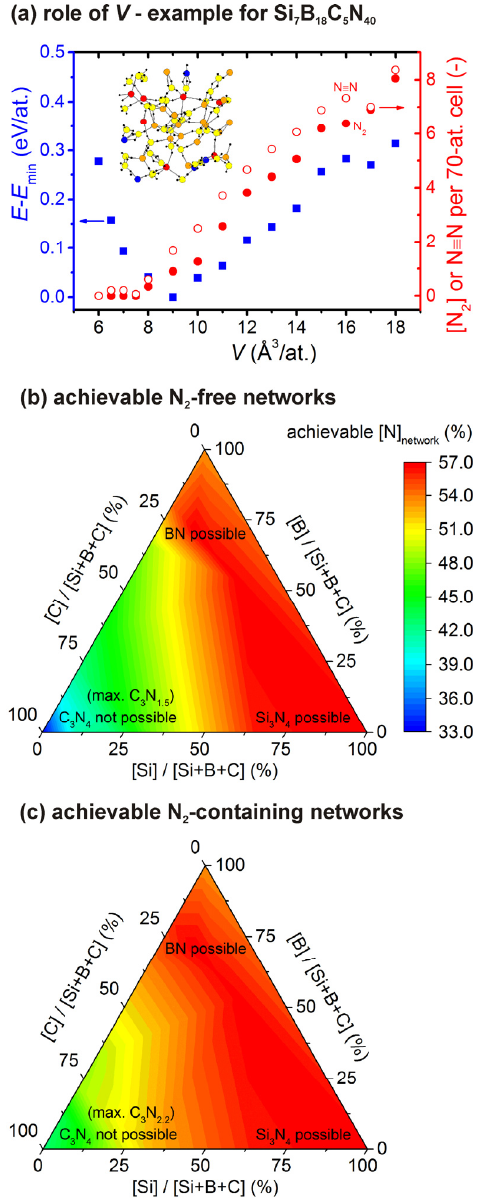
Figure 2. Panel ( a ) shows an example of the dependence of energy ( E - E min ; squares; left axis), number of unbonded N 2 molecules ([N 2 ]; full balls; right axis) and number of triple N ≡ N bonds (empty balls; right axis) on the inverse atomic density ( V ) for the composition of the 70-atom cell Si 7 B 18 C 5 N 40 . The inset is a snapshot taken at V = 9 Å 3 (red Si, orange B, blue C, yellow N, small black WFCs). Panels ( b , c ) show the maximum achievable content of N bonded in Si-B-C-N networks ([N] network ) without unbonded N 2, i.e., at [N] network ≈ [N] total (less than one N 2 per cell; panel ( b )) and at a presence of unbonded N 2, i.e., at [N] network < [N] total (panel ( c )).